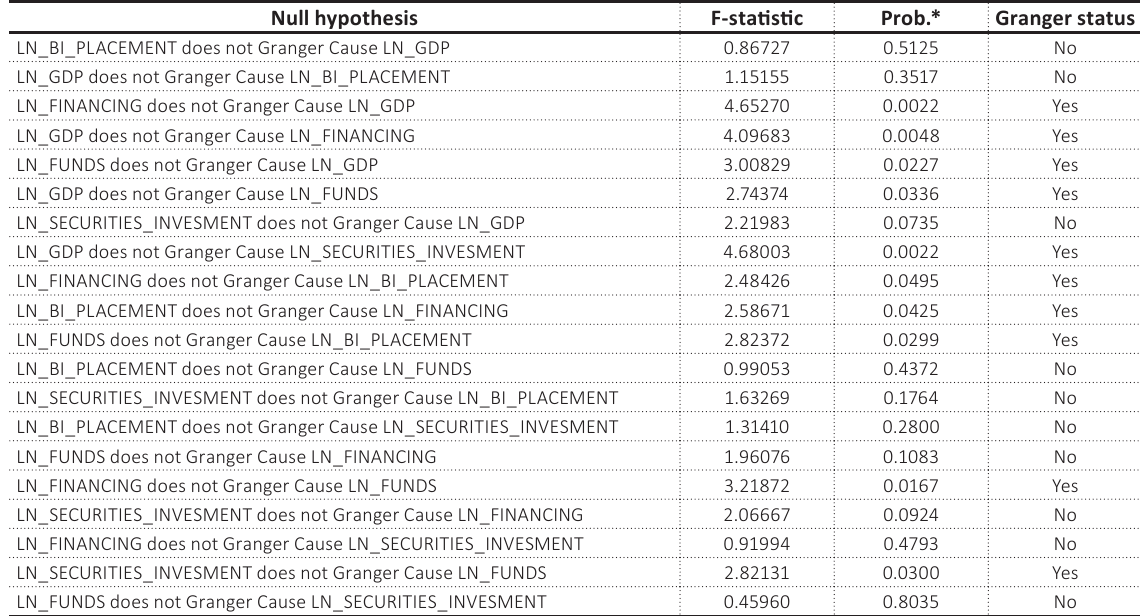
Table 4. Granger causality